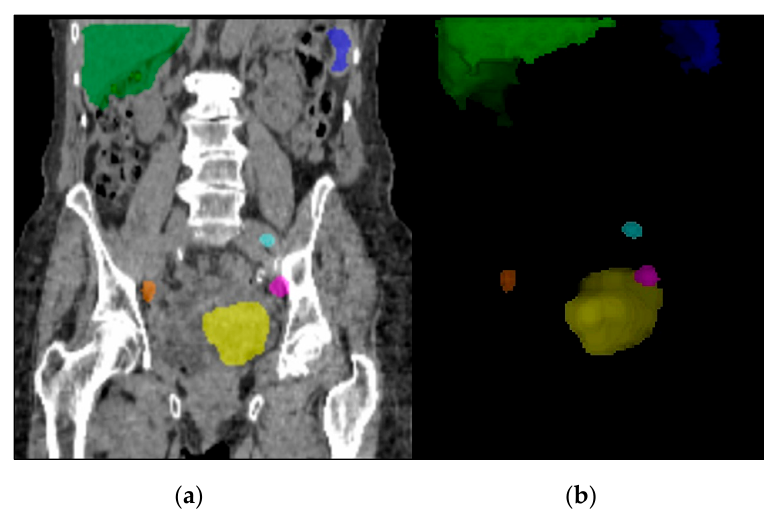
Figure 1. Segmented volume-of-interests (VOIs) for SPECT/CT quantification in an endometrial cancer (EC) patient. The case study shows VOIs for liver (green), spleen (blue), injection site (yellow), and three bilateral iliac SLNs (other colors) in coronal low dose CT ( a ) and in tridimensional representation of the regions ( b ).